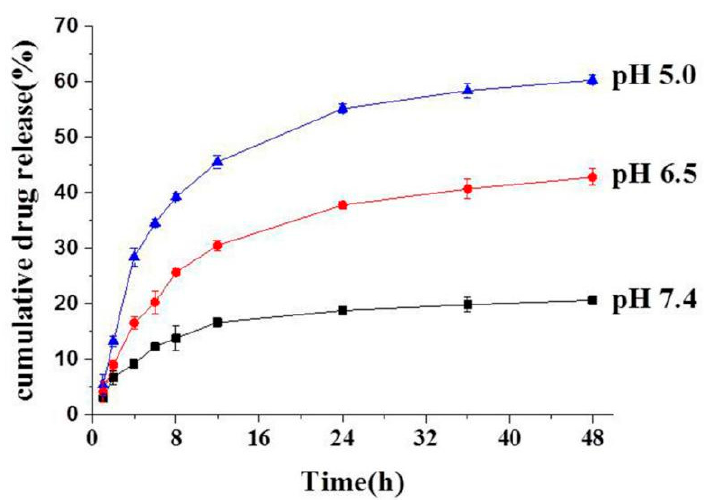
Figure 6. DOX release profiles of mPEG-PCL-Imi-DOX micelles under different pH levels. Data were presented as mean ± standard deviation (SD) ( n = 3).